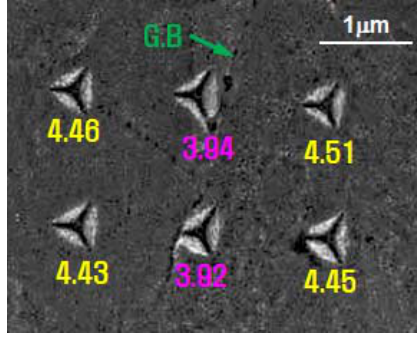
Figure 9. Nanoindentation results showing hardness at 700 °C.